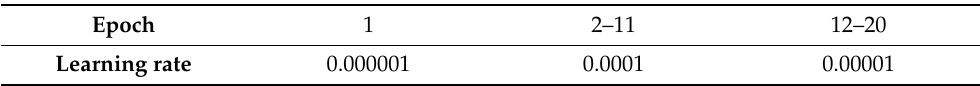
Table 1. The setting of the learning rate for the